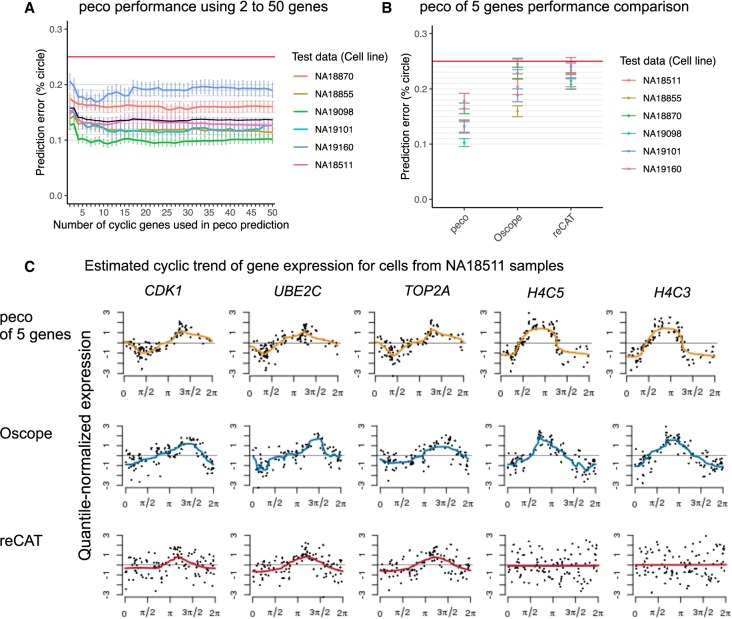
Inferring cell cycle phase from scRNA-seq data. (A) We applied sixfold cross-validation to test the performance of our predictor. In each fold, we trained our predictor on cells from five individuals and tested its performance on cells from the remaining individual. The y-axis corresponds to prediction error (between 0% to 25%, or π/4), and x-axis corresponds to the number of top cyclic genes used in the predictor. The six colored lines correspond to performances in the six folds, specifically average prediction error among cells in the test samples. Error bars, SEs. (B) Performance comparison of peco built from the top five cyclic genes (CDK1, UBE2C, TOP2A, H4C5, and H4C3) with Oscope (Leng et al. 2015) and recAT (Liu et al. 2017). (C) Estimated cyclic trend of top five cyclic genes for samples from cell line NA18511. The rows correspond to prediction results from peco of five genes, Oscope and reCAT. For the Oscope/reCAT results, we ordered the single-cell samples from NA18511 using the Oscope/reCAT-based predicted phase (based on 888 samples in the data) and used trendfilter to estimate cyclic trend of gene expression. For the peco results, we ordered the samples according to the predicted phase and used trendfilter to estimate cyclic trend of gene expression. The colored line corresponds to the estimated cyclic expression level along the predicted phase.